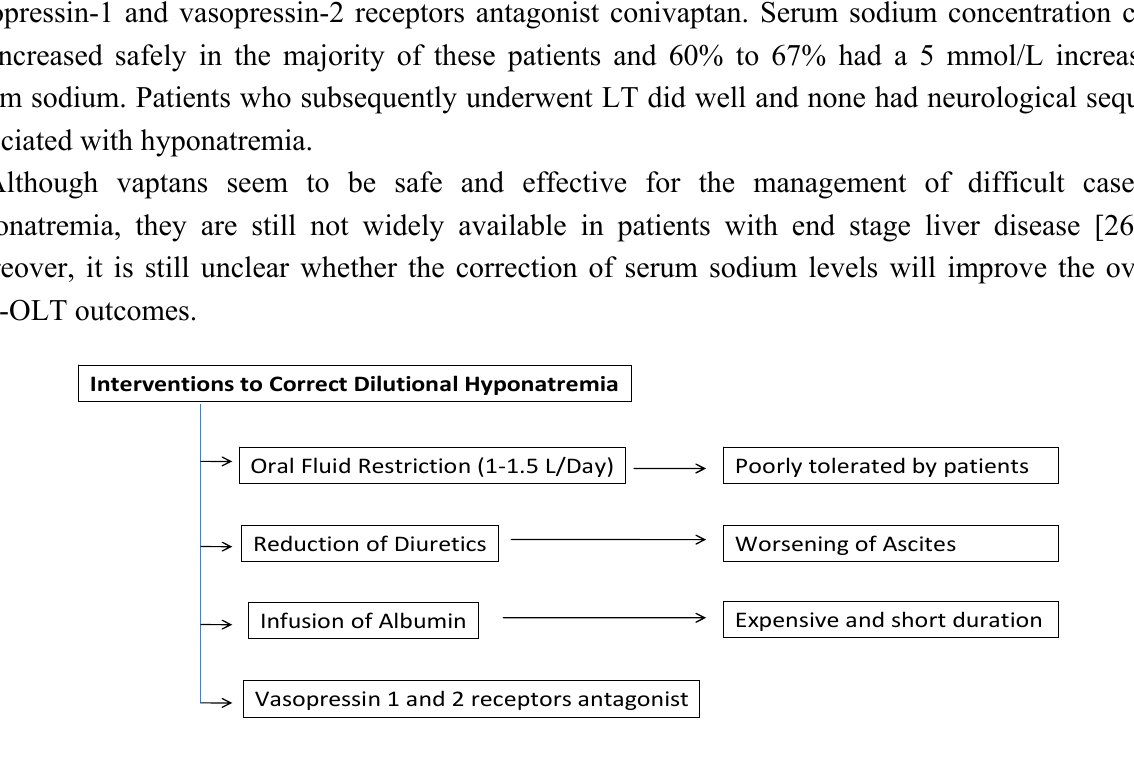
Figure 2. Interventions currently available to correct dilutional hyponatremia in cirrhotic